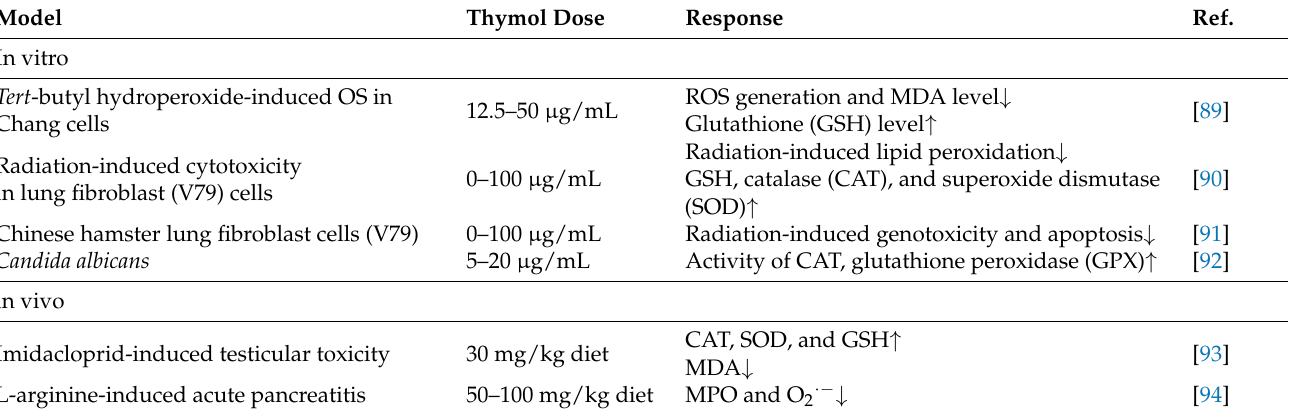
Table 3. Anti-oxidant properties of